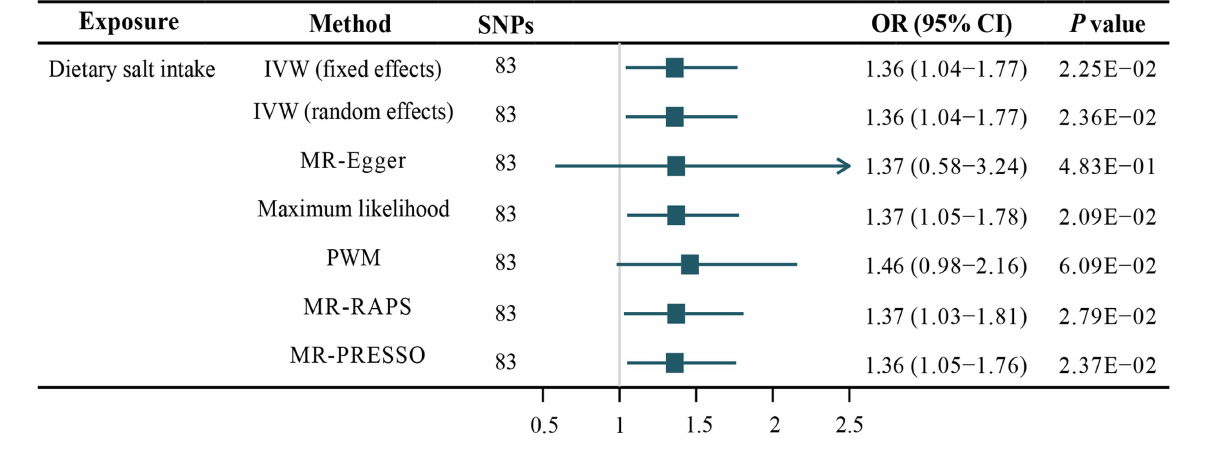
FIGURE 2 Association of dietary salt intake and the risk of atrial fibrillation. SNPs, single nucleotide polymorphisms; IVW, inverse variance weighted; MR-Egger, Mendelian randomization-Egger; PWM, penalized weighted median; MR-RAPS, Mendelian randomization robust adjusted profile score; MR-PRESSO: Mendelian randomization pleiotropy residual sum and outlier.